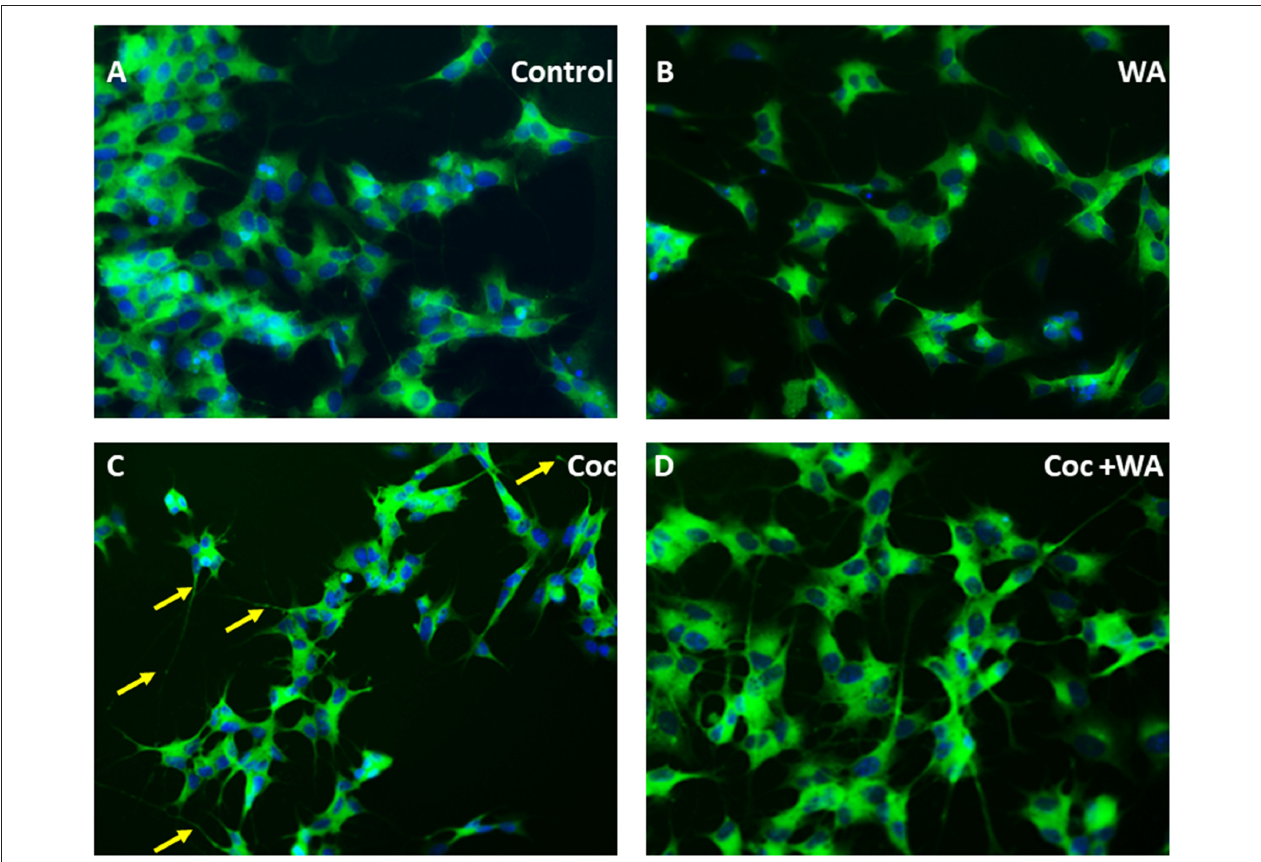
FIGURE 10 | WA reverses coc induced dendritic beading and cytoplasmic vacuoles. SH-APP cells were treated with coc (0.1 µ M) +/ − WA (2 µ M). After 24 h, cells were fixed and stained with MAP2 primary antibody overnight. Cells were washed and stained with secondary anti-rabbit FITC-labeled antibody (catalog #AP187F, Millipore). (A) Control SH-APP cells and (B) WA only treated cells showed no abnormal beading or thickening of the dendrites when compared to (C) coc exposed SH-APP cells which exhibited heavy dendritic beading (yellow arrows) and cytoplasmic vacuoles, measure of the cells being in drug-induced stress, (D) WA treated coc exposed cells on the other HIV-1 associated neurocognitive disorder (HAND) displayed reduced dendritic beading and elongated dendrites, with minimal cytoplasmic